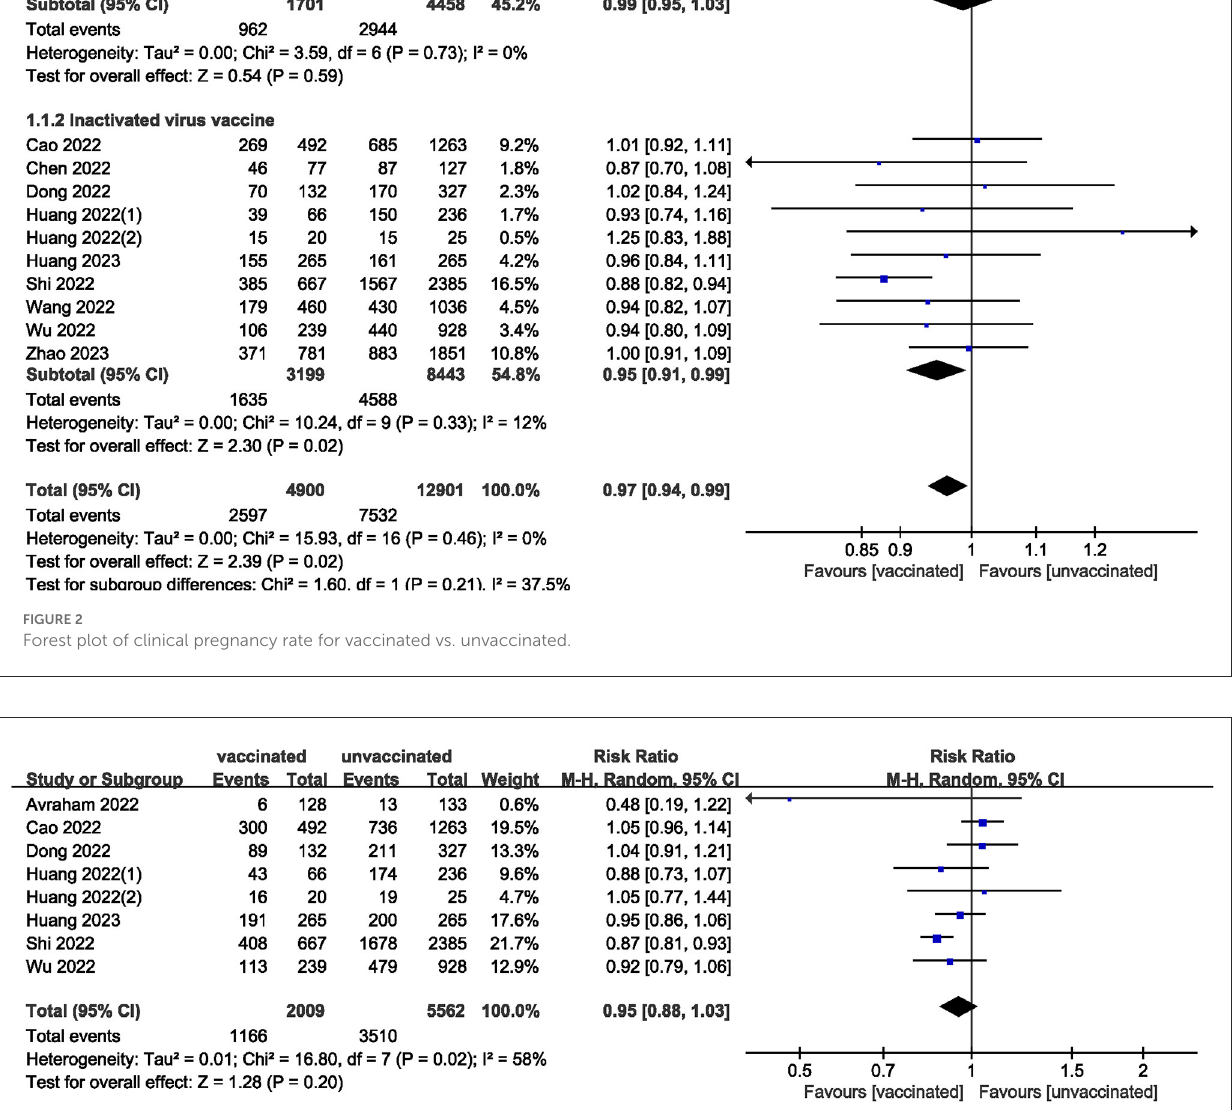
analysis of biochemical pregnancy rate (RR: 0.95; 95% CI: 0.88–